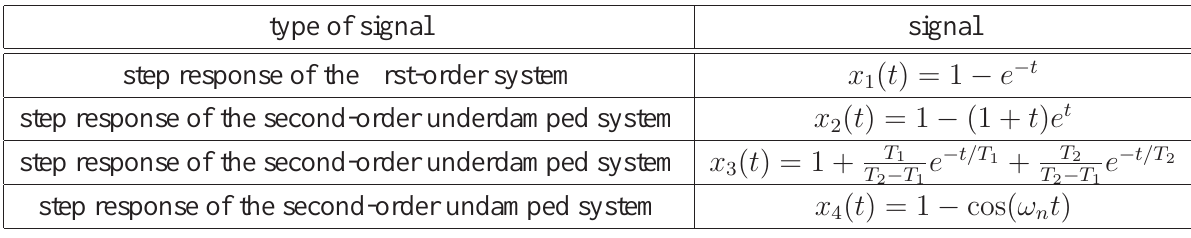
Table 2 . Four signals for the number of transmission test